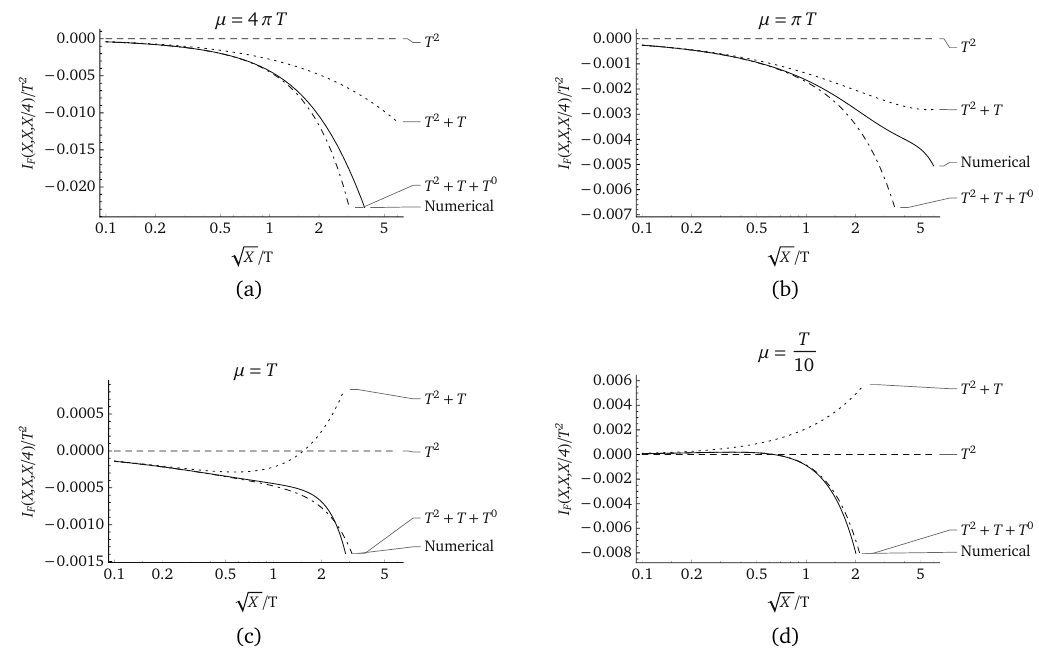
Figure 2: Comparison of the Fermionic high-temperature expansion with the numer- ical results for various µ = cT scalings. The two fermionic masses are (cid:112) X bosonic mass is . The sunset integral is normalized with T − 2 . Comparison 2